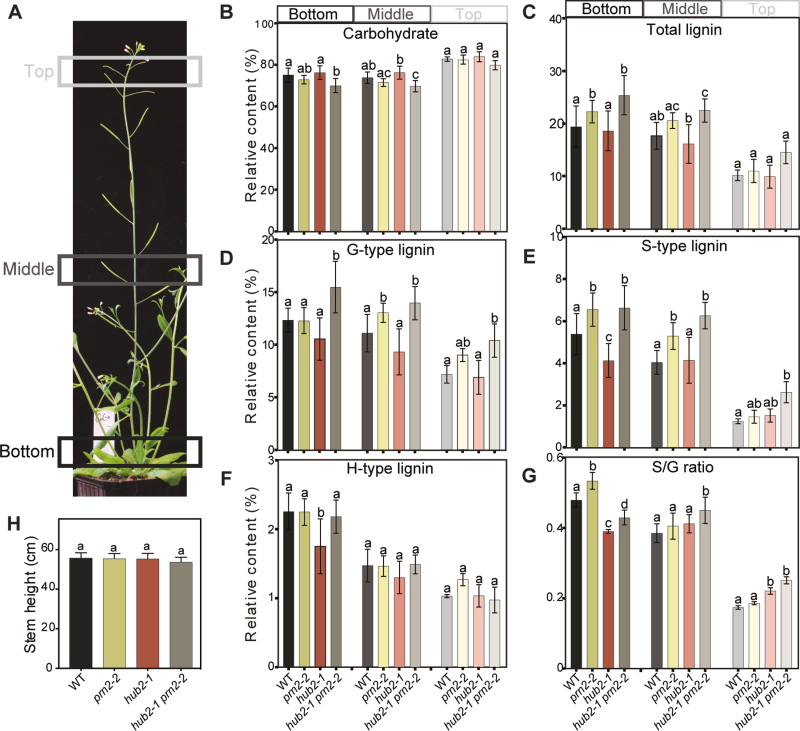
HUB2 influences the S-type lignin content of Arabidopsis stems. (A) Photograph illustrating the inflorescence stem fragments used for Py-GC/MS analysis. The bottom, middle, and top part of 55 cm long inflorescence stems of WT, prn2-2, hub2-1, and hub2-1 prn2-2 were analysed. (B–G) Py-GC/MS analysis determining the relative amounts of carbohydrates (B), total lignin (C), G-type lignin (D), S-type lignin (E), and H-type lignin (F), and the S/G ratio (G) based on their respective MS peak area as a proportion of the cumulative area from all peaks (Gerber et al., 2012). For each genotype, five biological replicates were analysed, each composed of a pool of three stem fragments. (H) The height of the inflorescence stems used for the analysis. Lines that do not share any letter are significantly different from each other according to post-ANOVA Fisher’s test (n≥3, P<0.05). Error bars indicate ±SD.